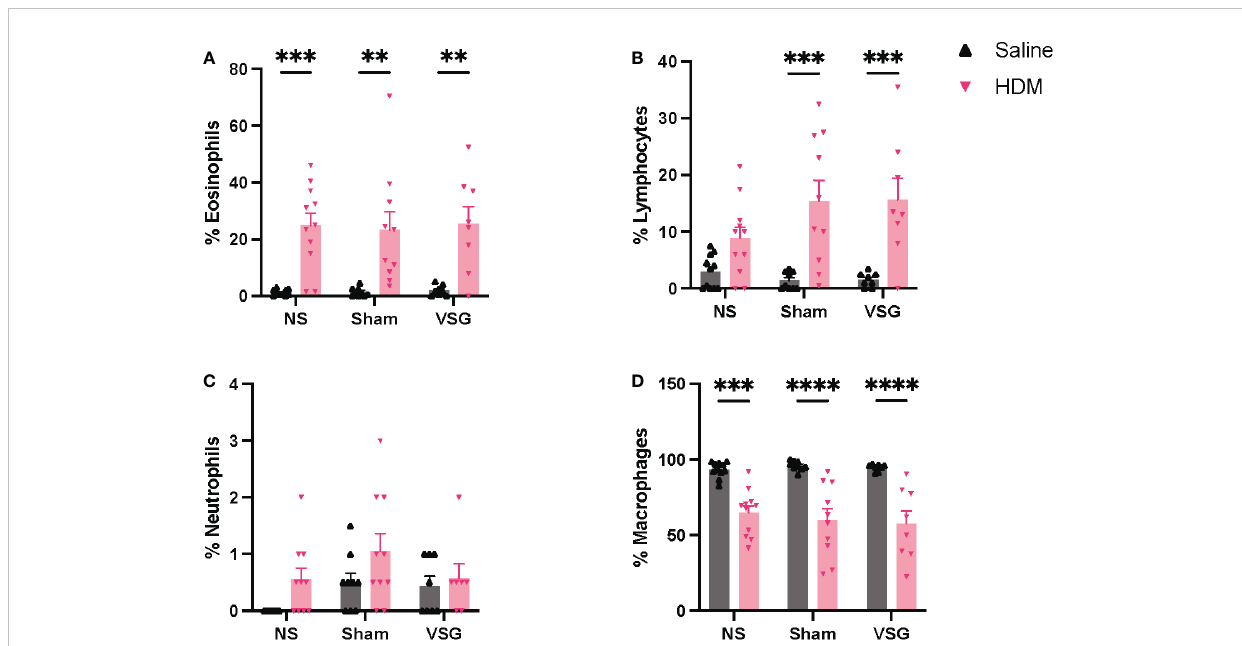
FIGURE 5 BAL fl uid cellularity. Relative percentages of (A) eosinophils, (B) lymphocytes, (C) neutrophils, and (D) macrophages in BAL fl uid, n=7-11 mice per group. Grey bars and ▲ = saline-challenged mice; pink bars and ▼ = HDM-challenged mice. (A – D) were analyzed using a Two-way ANOVA with a Tukey and Sidak post-hoc test. **p<0.01, ***p<0.001,